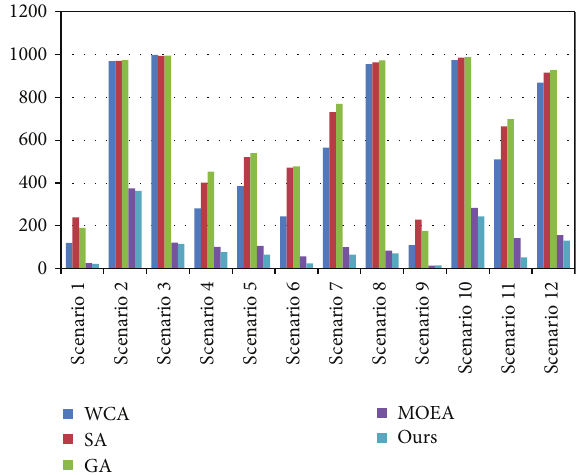
Figure 3: Number of reclusterings.